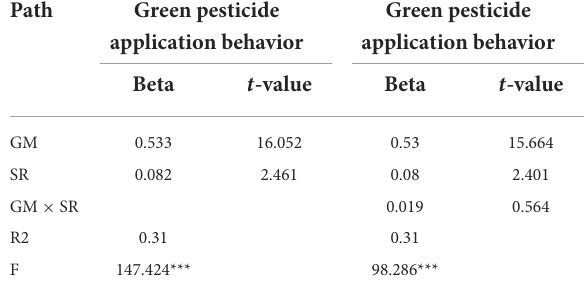
TABLE 12 Test of social regulation effect.